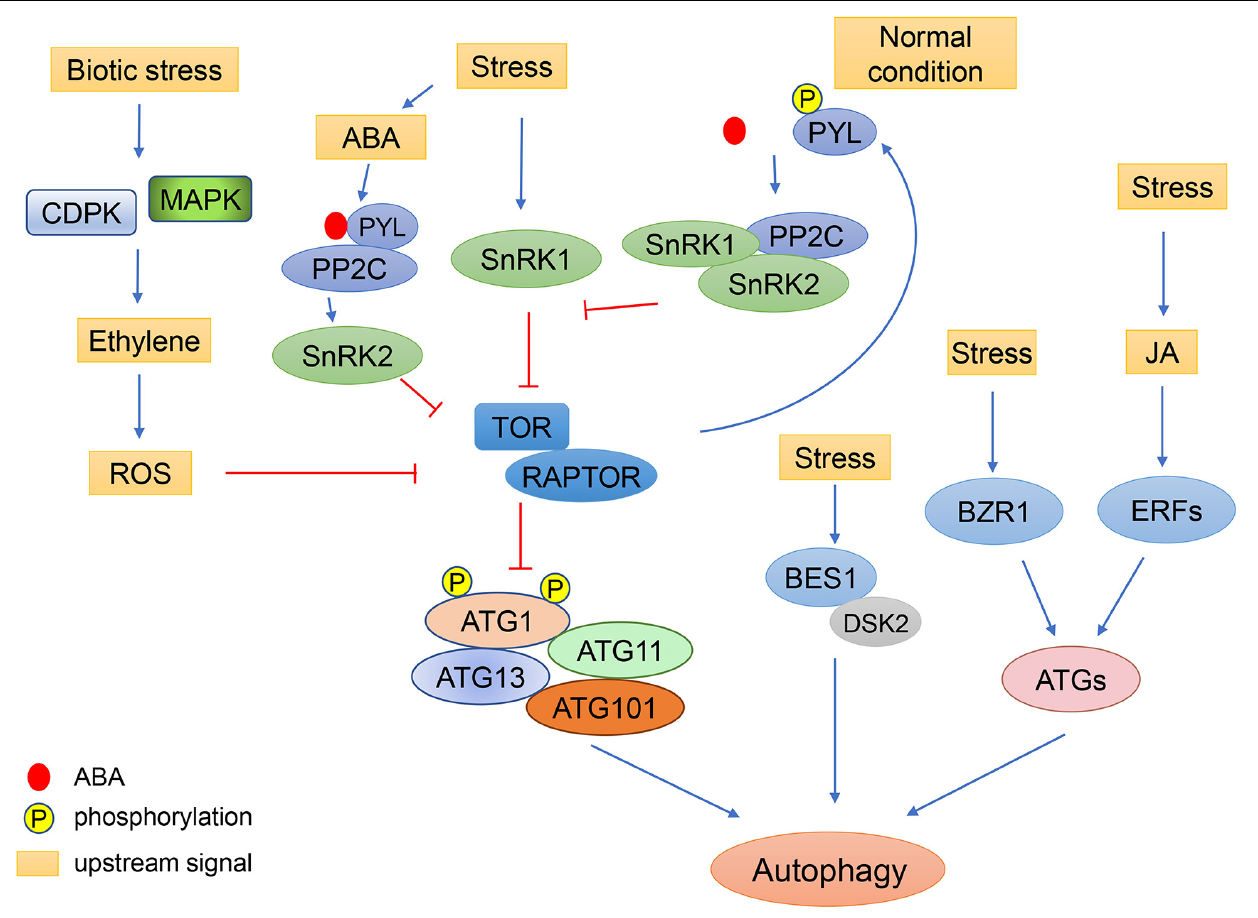
FIGURE 3 | Schematic diagram of autophagy regulation by environmental stress through plant hormones. Under stress conditions, the concentration of ABA increases. ABA receptors, PYLs, bind to ABA and PP2C, resulting in the activation of SnRK2. SnRK2 phosphorylates RAPTOR and inactivates the TOR complex to induce autophagy. Under normal conditions, TOR kinase phosphorylates the PYL ABA receptors, preventing PYL from binding to ABA and PP2C. SnRK2 and PP2C form repressor complexes which interact with SnRK1 and prevent it from interacting with TOR. In response to biotic stress, ethylene signaling is activated by MAPK and CDPK. The ethylene signaling pathway may regulate autophagy through ROS signaling. Abiotic stresses also regulate autophagy through the JA pathway, in which the expression of ATGs can be induced by ERFs. Additionally, cold can enhance the stability of BZR1 to increase expression of ATGs, resulting in enhanced autophagy. The brassinosteroid-responsive transcription factor BES1 is selectively degraded by DSK2-mediated autophagy under starvation and drought stresses.